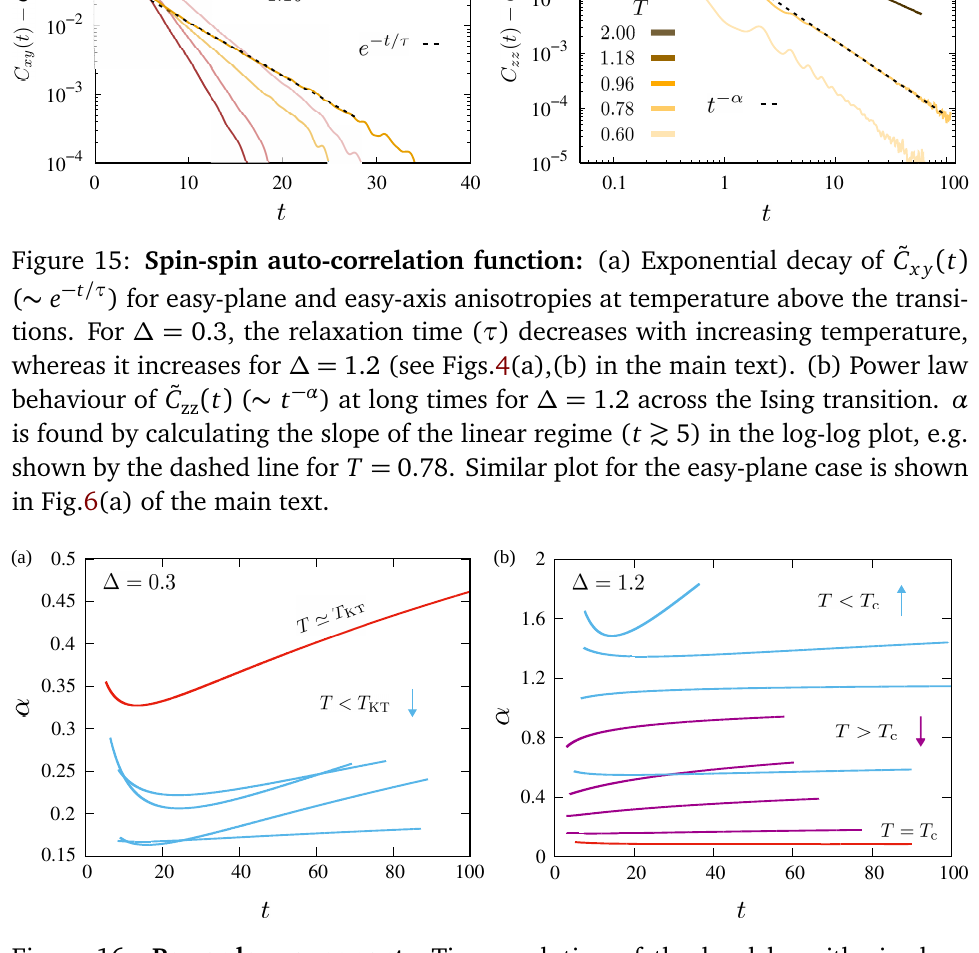
Figure 16: Power-law exponent: Time evolution of the local logarithmic slope α ( t ) = d ln ( C ( t )) / d ln t for (a) ∆ = 0.3 and T = 0.72,0.68,0.64,0.60 and 0.55, where C = ˜ C , and (b) ∆ = 1.2, across the Ising transition with C = ˜ C x y T = 2.00,1.26,1.10,1.00,0.96,0.90,0.82,0.78 and 0.74. Different temperature regimes are marked with different colors. The direction of the arrows indicates the decrement of